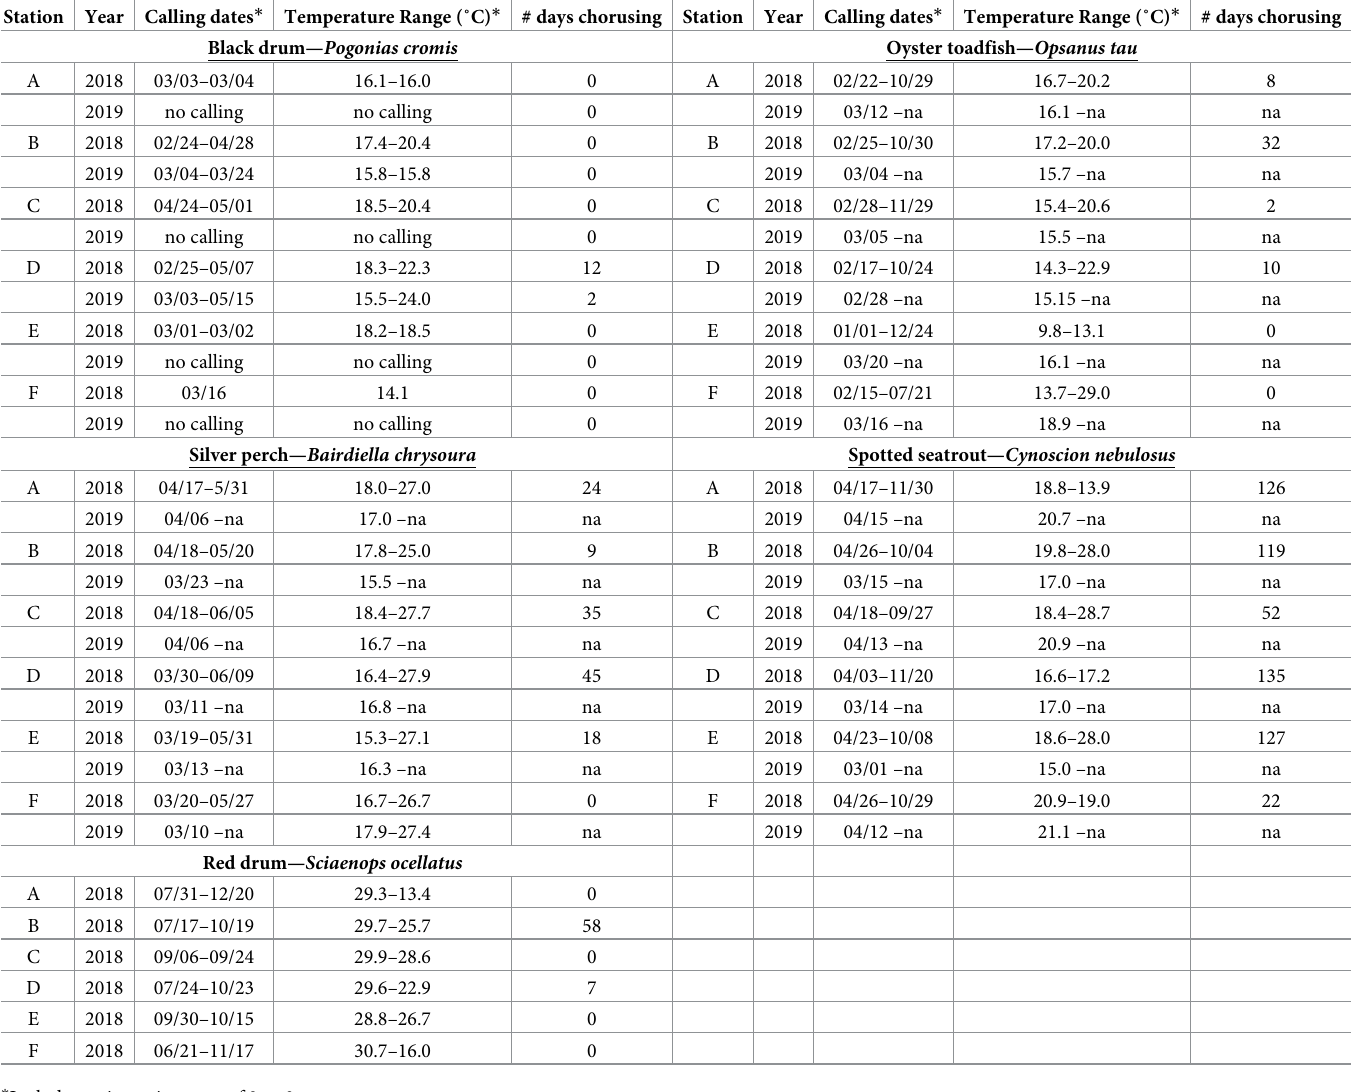
Table 4. Calling timelines and number of days chorusing (i.e. intensity score = 3) for fish species at each station.